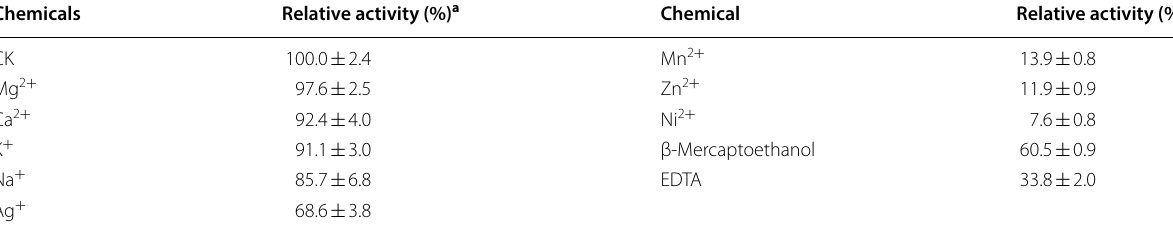
a Values are given as the mean